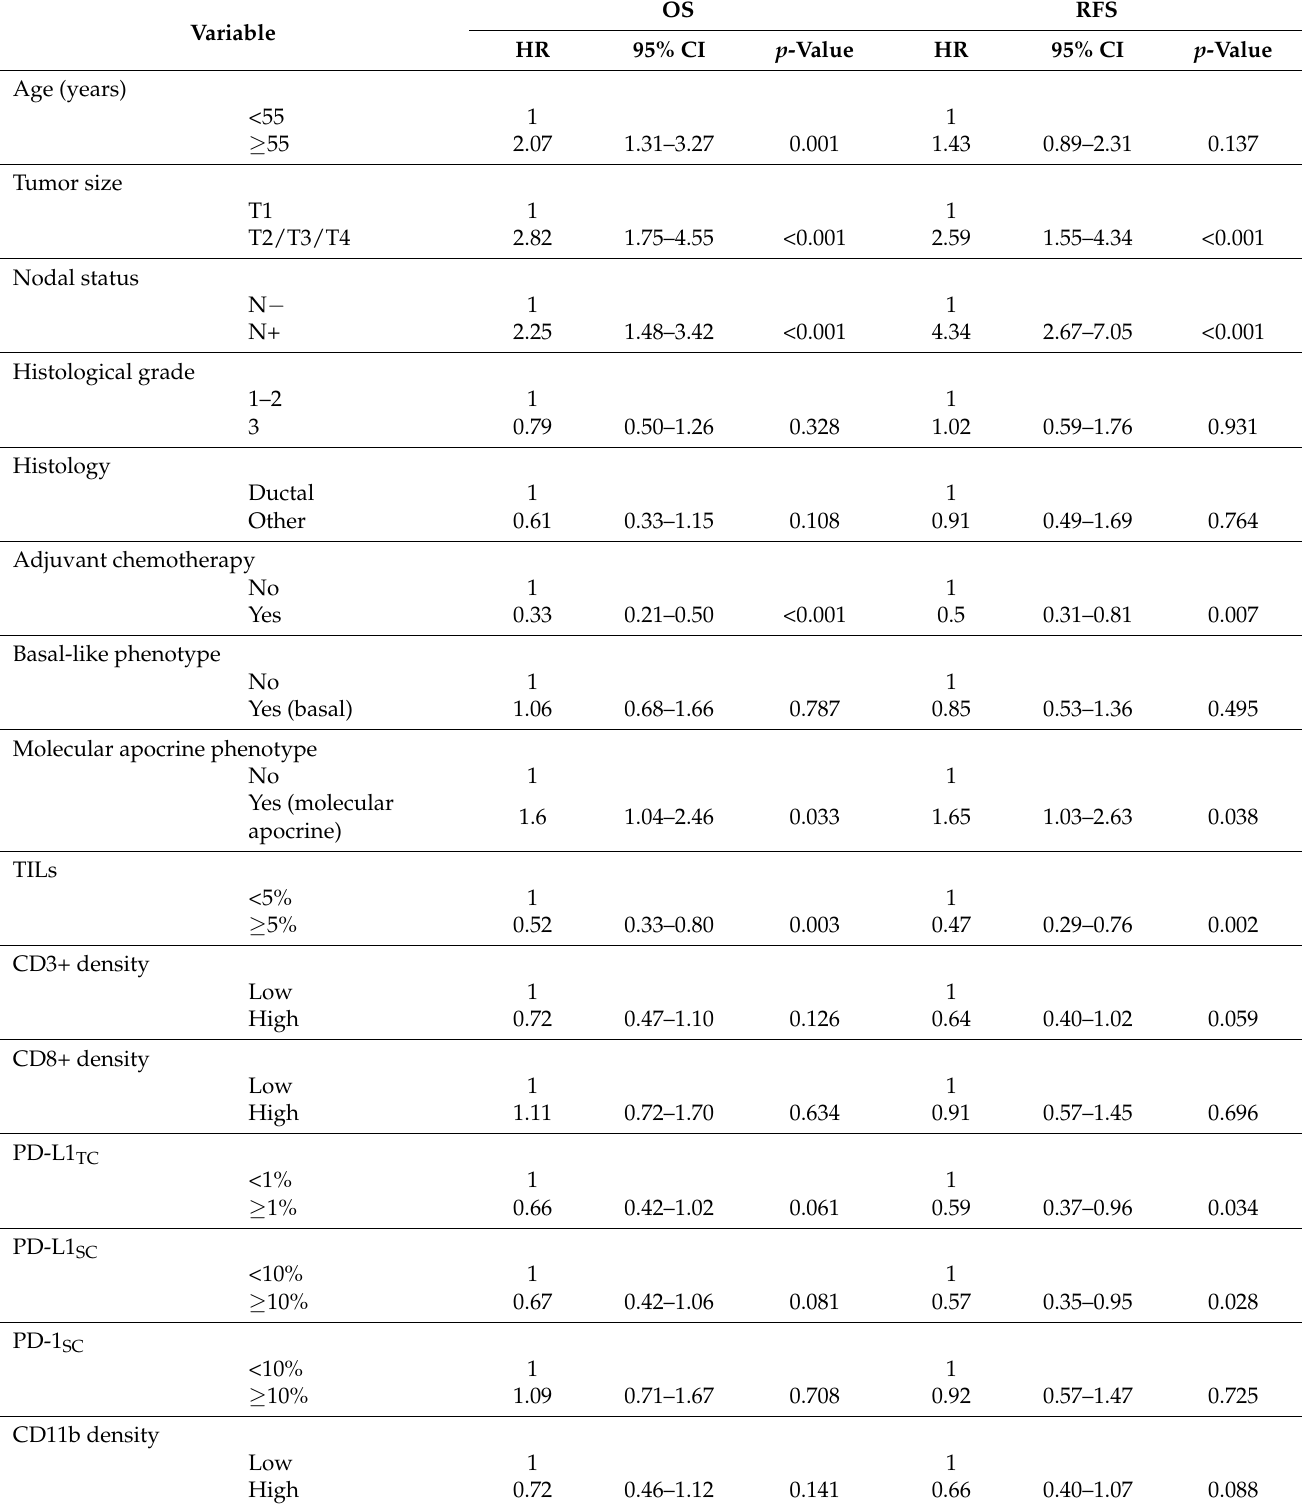
Table 4. Univariate analysis of